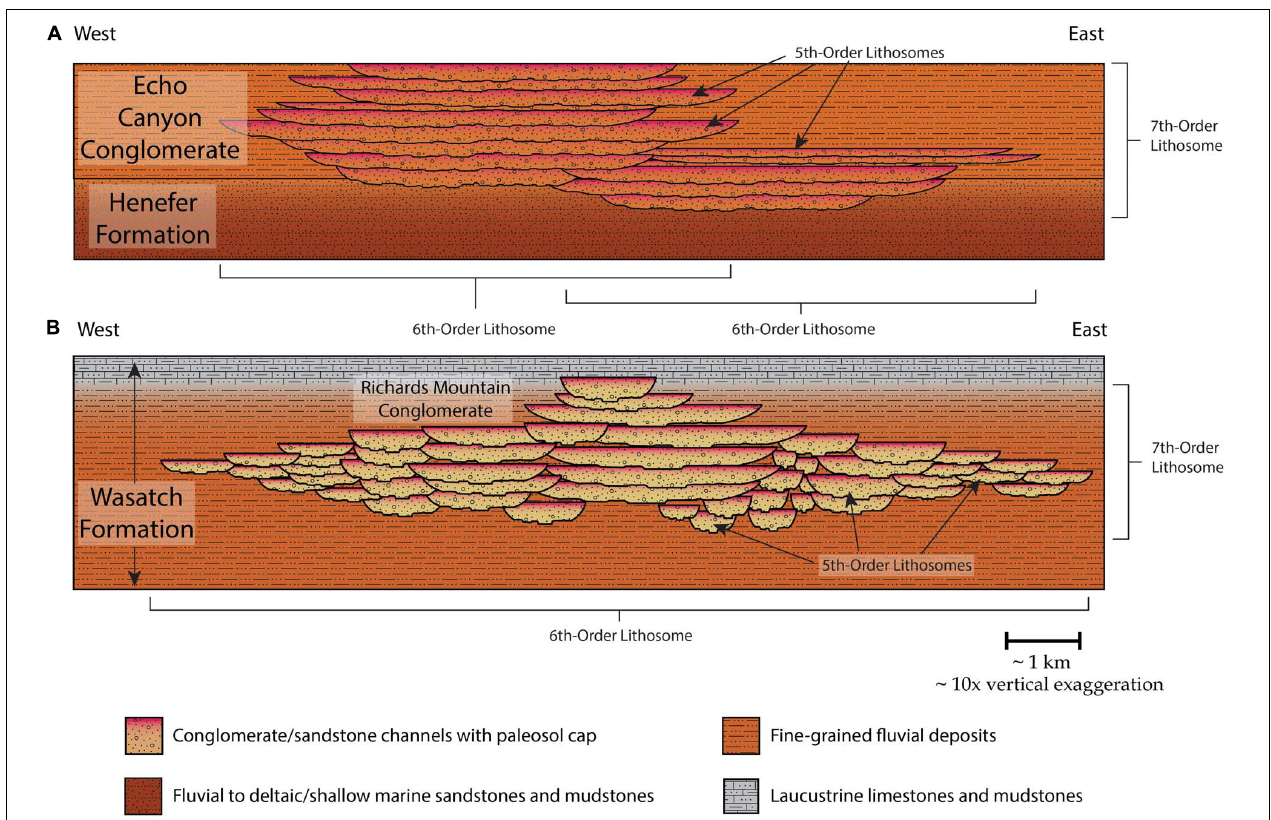
FIGURE 12 | Simplified representation of the architectural styles of the Echo Canyon Conglomerate (A) and the Richards Mountain Conglomerate (B) . Width:height ratios of fifth-order lithosomes are represented at their correct relative sizes between the two fans (with approximately10 × vertical exaggeration). Stacking patterns of fifth-order lithosomes are represented schematically for both fans. While the dimensions, placement, and number of fifth-order lithosomes do not exactly match the actual deposits, general trends in the dimensions and placement of lithosomes do accurately represent the real study areas. Note that in the Echo Canyon Conglomerate, fifth-order lithosomes are organized into multiple sixth-order lithosomes (individual alluvial fans). Contrast this with the Richards Mountain Conglomerate, where the fifth-order lithosomes comprise only one, larger sixth-order lithosome. Note also that at Echo Canyon, the fifth-order lithosomes extend laterally across essentially the entire sixth-order lithosome that contains them, while at Richards Mountain the fifth-order lithosomes extend laterally across only a relatively small portion of their sixth-order